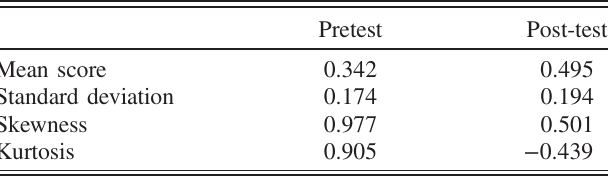
TABLE I. Pre- and post-test statistics, N ¼ 427